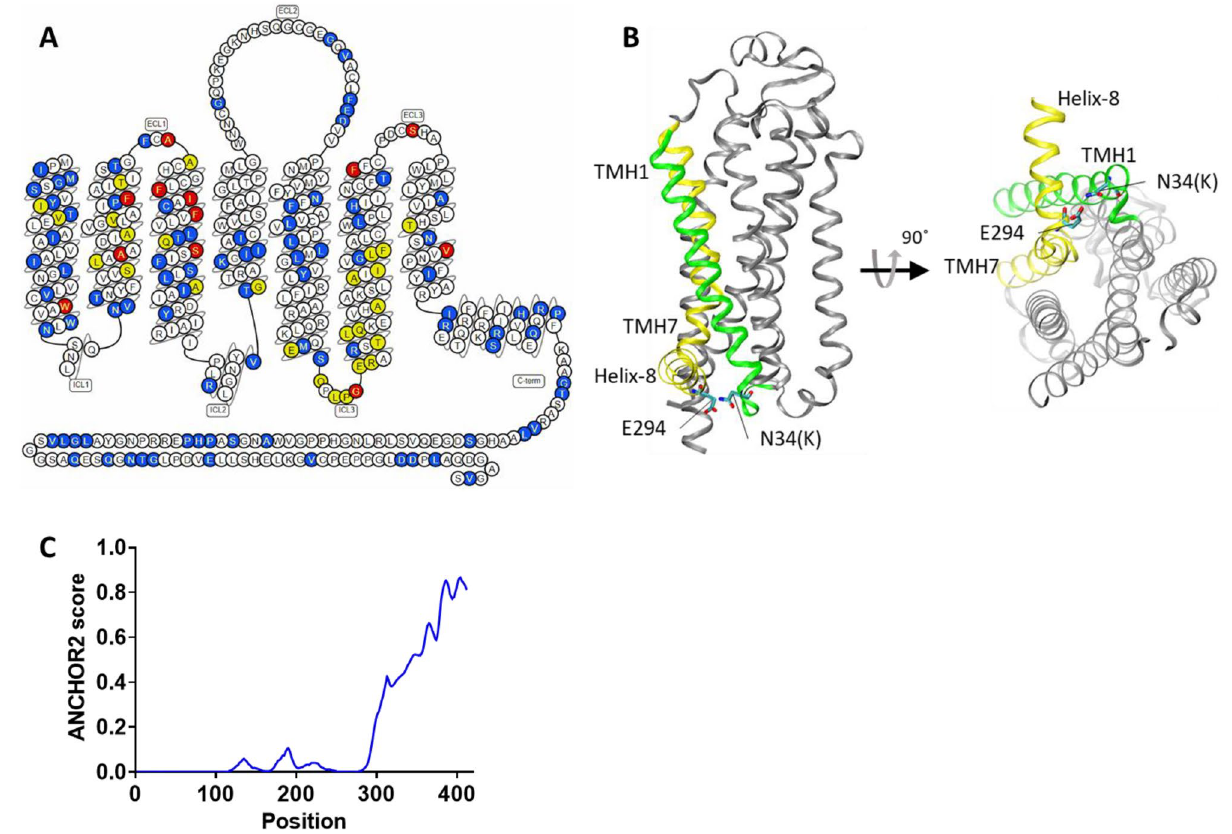
Figure 6. A2aR scaffold is highly amenable to stabilization. ( A ) The snake-plot of A2aR-WT highlights the positions of stabilizing mutations. In yellow—positions of Ala/Leu substitutions conferring thermostability upon the agonist-bound receptor 12 . In blue—positions of substitutions occurring in OG resistant A2aR variants identified by the YDDS (this study). In red, position identified by both studies. ( B ) A single N34K substitution in c7 variant confers OG resistance and thermostability upon A2aR. The A2aR structure (PDB: 4UG2) is shown in cartoon representation. The TMH1 and TMH7 are colored in green and yellow, respectively. ( C ) The C-terminus of A2aR is intrinsically disordered. The ANCHOR2 plot shows the probability (indicated by ANCHOR2 score) of the given A2aR-WT residue being part of a disordered binding region (default settings were used) 34